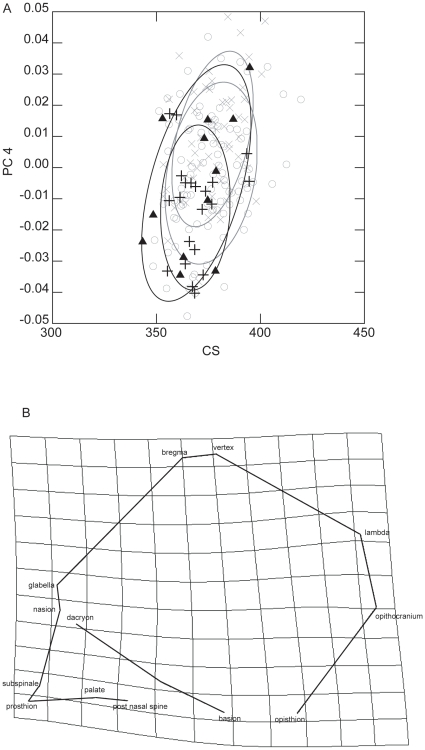
Differentiation explained by allometries and between-groups variation.(A) Samples distribution according with CS vs. PC4. Ellipses represent the 95% confidence interval of distributions for each sample. X: Eastern non-pygmies; O: Western non-pygmies; Δ: Eastern pygmies; +: Western pygmies. (B) Transformation grids on PC4 in lateral (left) view. Eastern non-pygmies were considered the reference and Western pygmies, the target. Frontal and basal views do not represent any important variation.